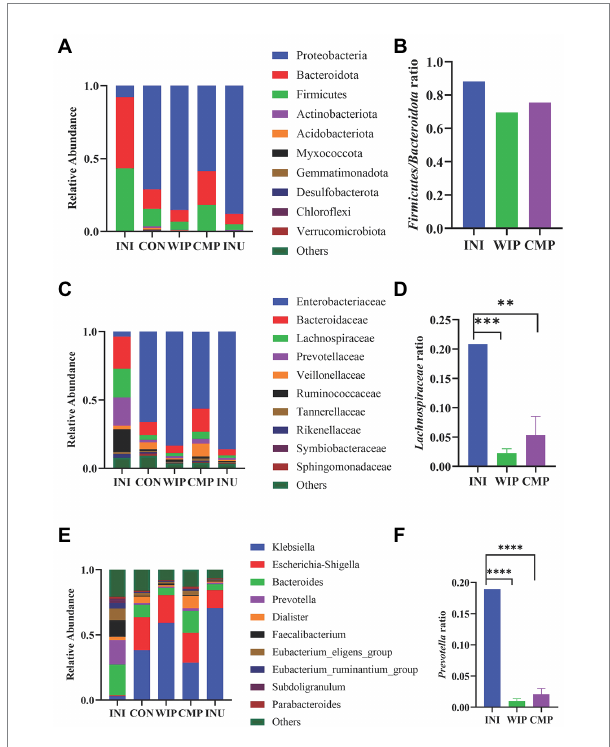
FIGURE 12 Effect of WIP on gut microbiota composition. (A) Phylum level, (B) Firmicutes/Bacteroidetes ratio, (C) family level, (D) Lachnospiraceae ratio, (E) genus level, and (F) Prevotella ratio. ** p < 0.01, *** p < 0.001, and **** p <